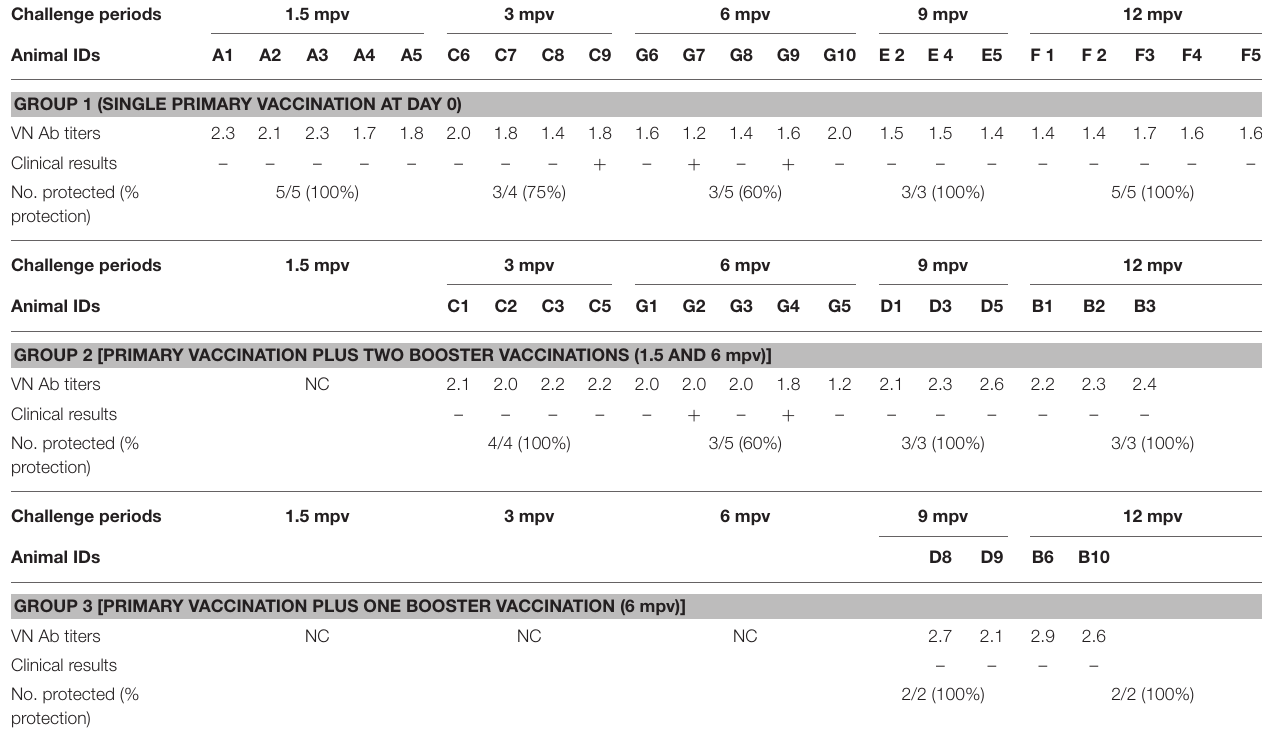
TABLE 5 | Duration of immunity after three vaccination groups: VN antibody titers at the time of challenge and clinical results post-challenge. Challenge periods